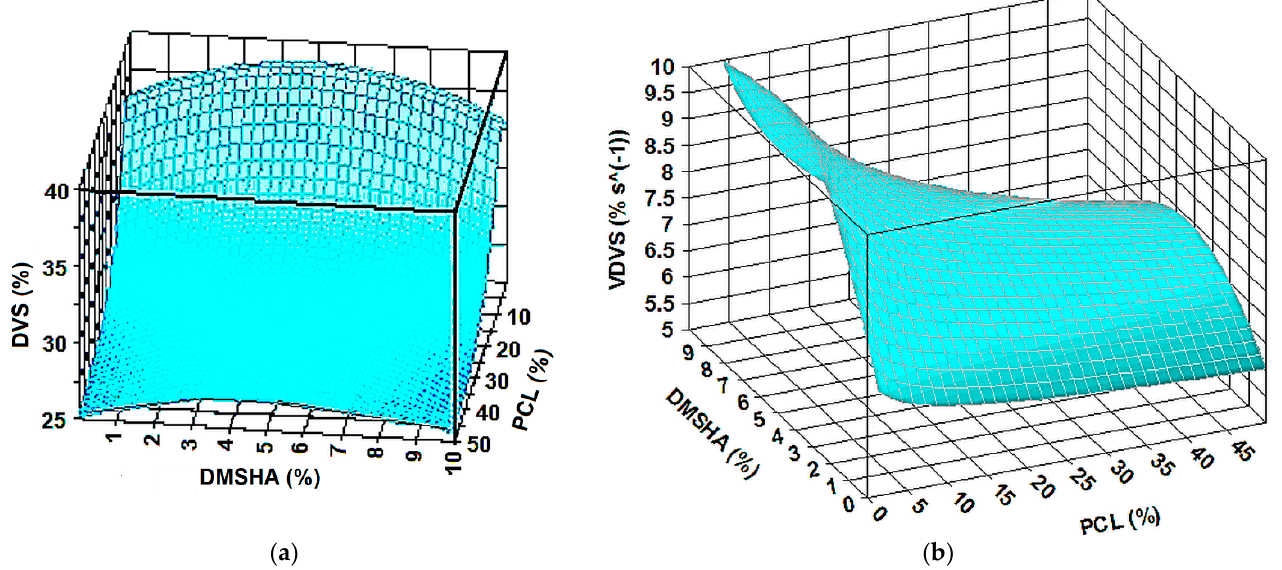
Figure 2. Water vapour sorption dependence on composition: ( a ) dynamic water vapour sorption capacity; ( b ) rate of dynamic water vapour sorption.